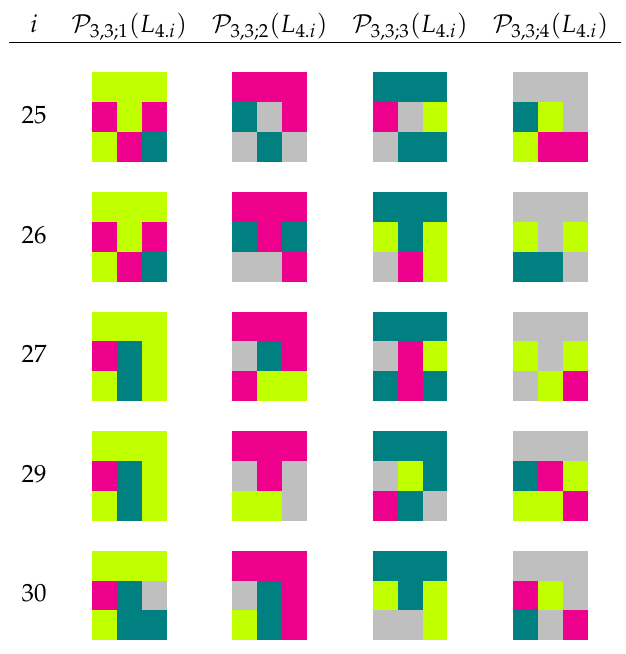
Figure 4. Standard 3 × 3 image patterns associated to L 4.25 , L 4.26 , L 4.27 , L 4.29 and L 4.30